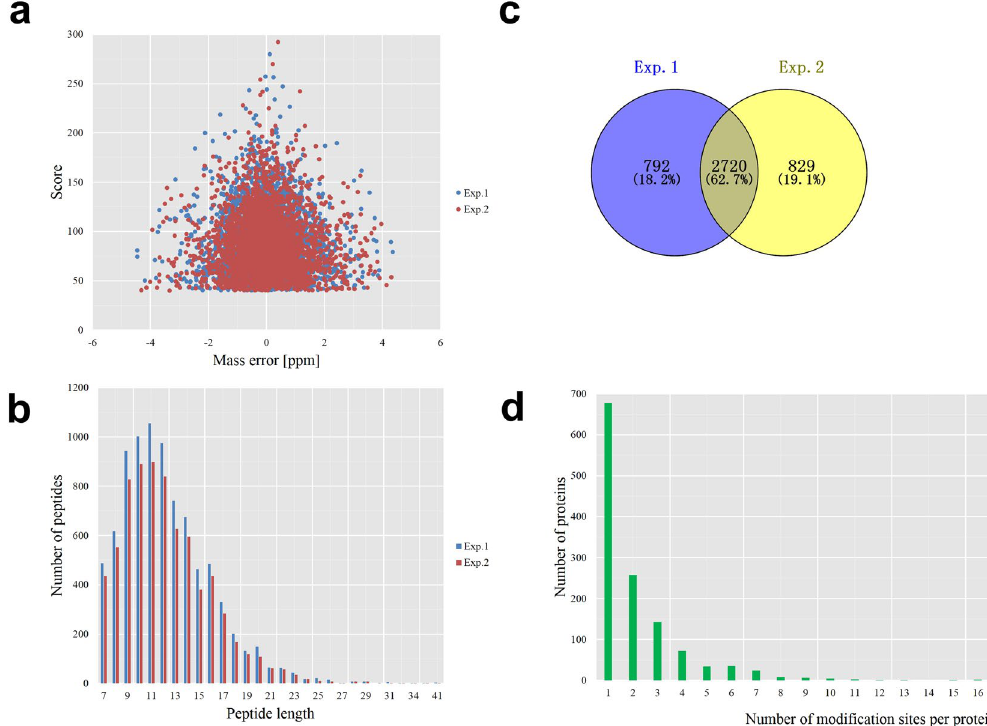
Figure 1. QC validation of MS data and summary of acetylated proteins. ( a ) Mass error distribution of all identified peptides, ( b ) Peptide length distribution. ( c ) Venn diagram representing the number of acetylation sites for the two biological replicate analysis, ( d ) Distribution of acetylated proteins based on their number of acetylation